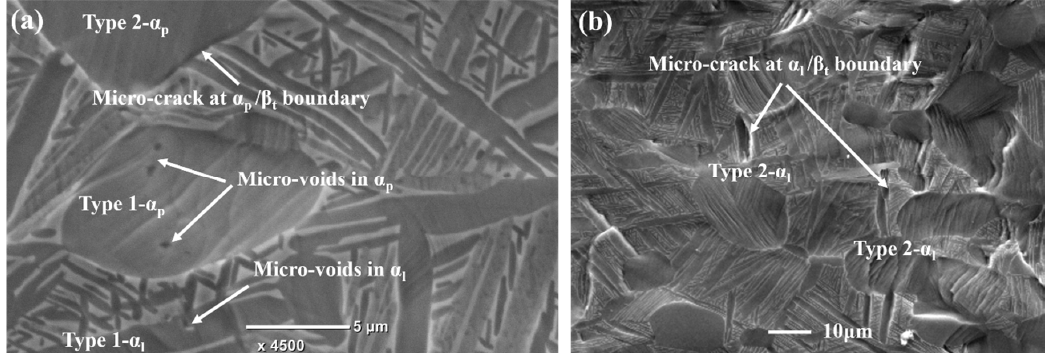
Figure 10. The micro-damage features of tri-modal microstructure after larger tensile deformation: ( a ) micro-voids within α p and α l and micro-crack at α p / β t boundary; ( b ) micro-crack at α l / β t boundary (the sample surface was mechanically and electrolytically polished before tensile deformation).